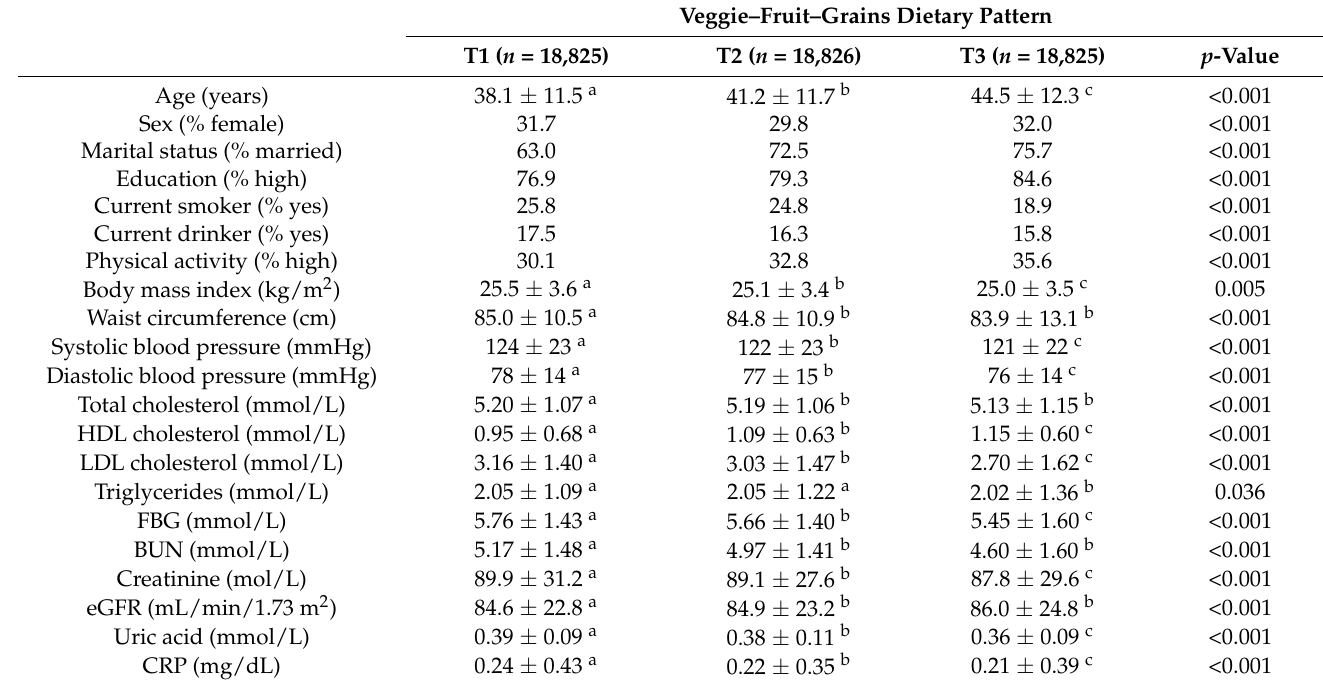
Table 4. Characteristics of the subjects across tertiles of the veggie–fruit–grains dietary pattern ( n = 56,476) 1 . Veggie–Fruit–Grains Dietary